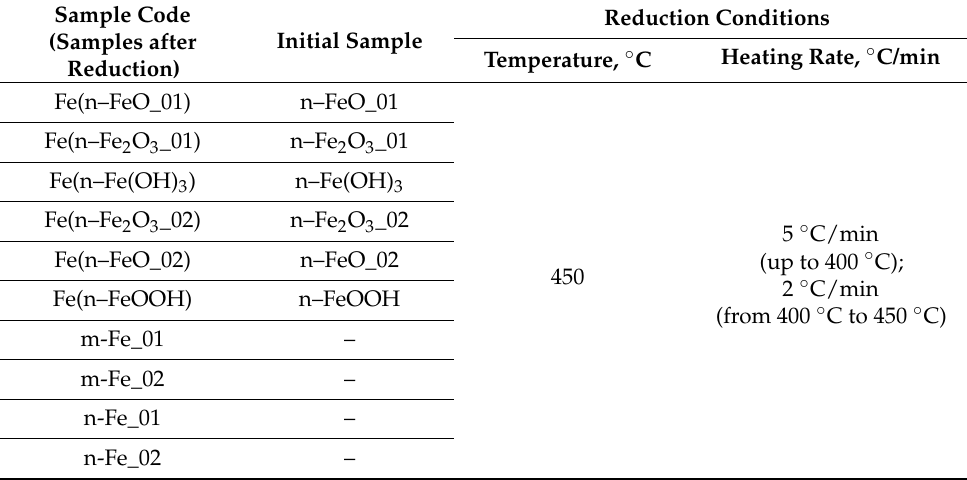
Table 2. Reduction conditions of iron-containing